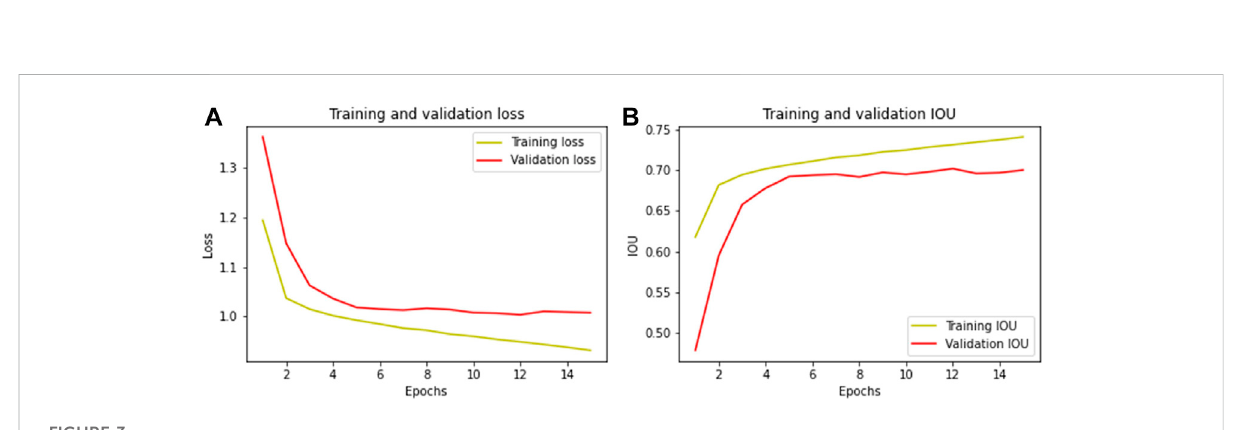
FIGURE 3 Metrics [ (A) : Loss, (B) : IOU] of the model during training and